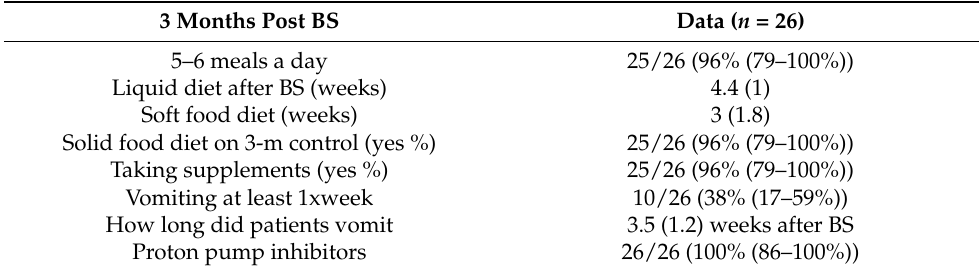
Table 6. Dietary patterns and gastric complications after bariatric